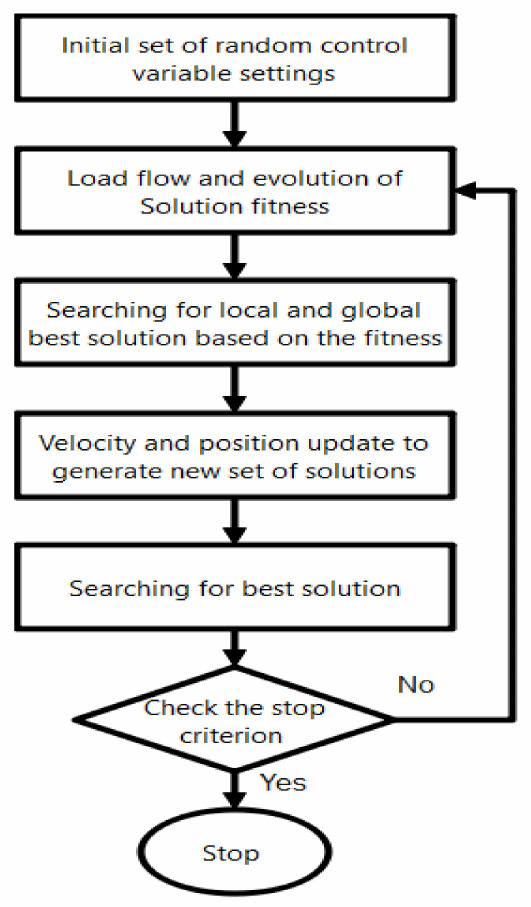
Figure 4. Flowchart of the particle swarm optimization (PSO)